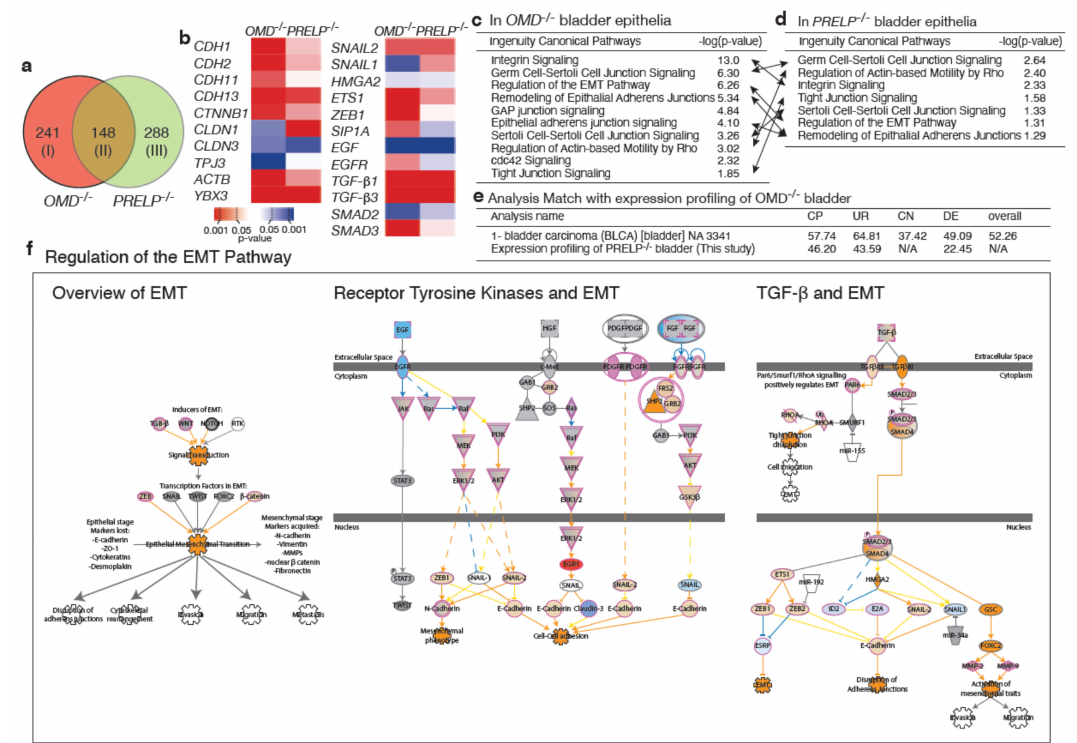
Figure 8. Expression profiling of OMD − / − , PRELP − / − mouse bladder epithelia. Expression profiling was performed using OMD − / − , PRELP − / − mouse bladder epithelia. Data were analyzed, and the following figures were made through the use of IPA (QIAGEN Inc., https: // www.qiagenbioinformatics.com / products / ingenuitypathway-analysis). ( a ) Significantly affected gene numbers, including both up and downregulated. ( b )Expressionofgenesrelatedtocell–celladhesionandEMT.( c,d )Significantlyaffectedcelladhesion-related pathways in OMD − / − ( c ) and PRELP − / − ( d ). The same pathways are connected by arrows. ( e )